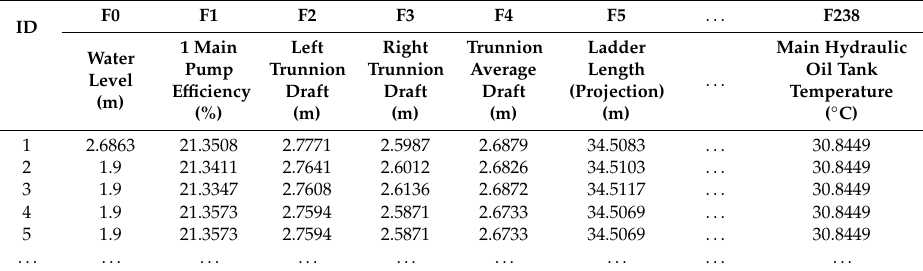
Table 1. Monitoring data structure of the cutter suction